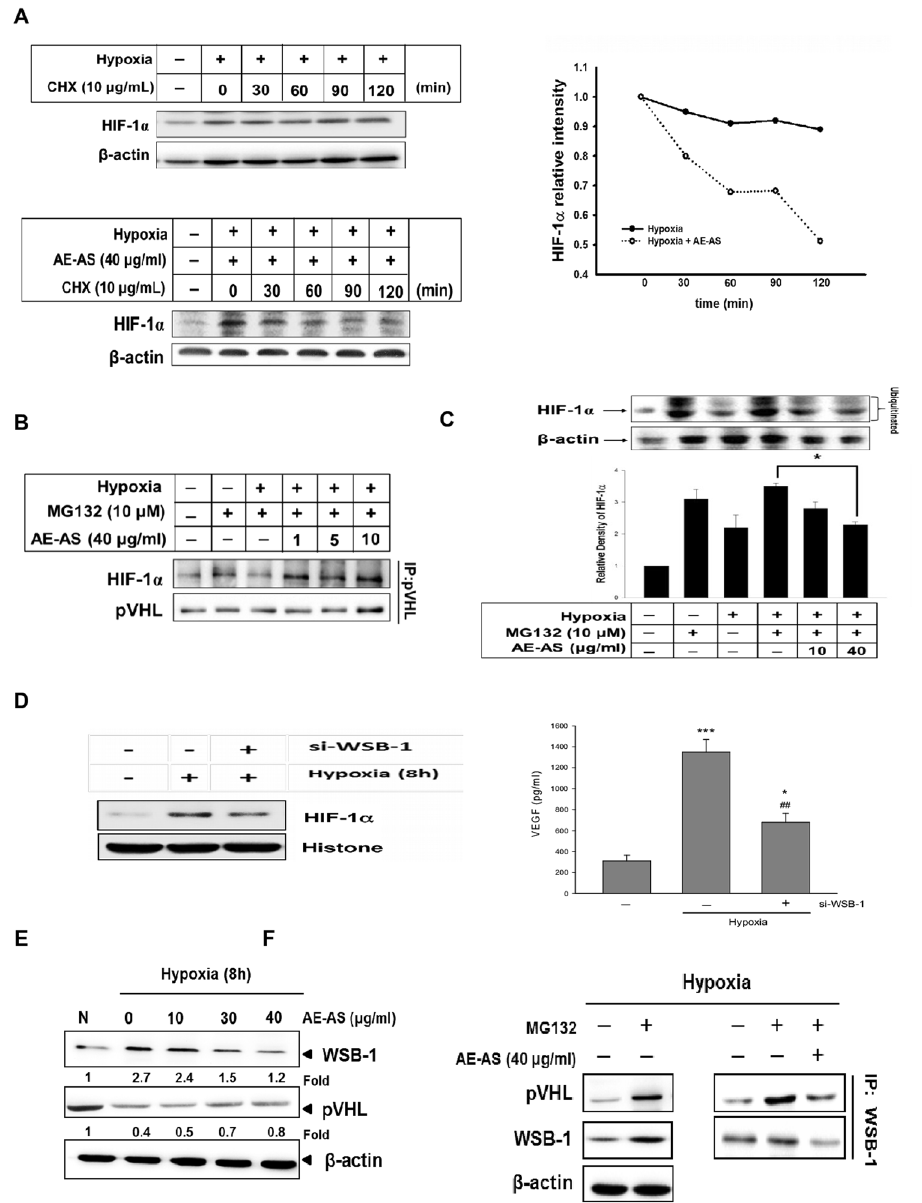
Figure 3. AE-AS decreased HIF-1 α protein degradation and synthesis, and WSB-1-pVHL interaction in hypoxic T24 cells. T24 cells were exposed to hypoxia for 8 h followed by addition of cycloheximide (CHX, 10 μ g/ml) in the presence or absence of AE-AS (40 μ g/ml) for different time periods. The HIF-1 α protein levels at indicated time were analyzed ( A ). In the presence of proteasome inhibitor MG132 (10 μ M) and hypoxia, the interaction of pVHL and HIF-1 α in various groups was examined ( B ). The T24 cells were pretreated with MG- 132 for 1 h followed by exposure of hypoxia for 8 h in the presence or absence of AE-AS, and the HIF-1 α protein levels were determined ( C ). Data was expressed as mean ± SEM (n = 5). * P < 0.05 versus hypoxia and MG132- treated alone cells. The nuclear protein level of HIF-1 α and VEGF synthesis in the presence or absence of si- WSB-1 in hypoxic T24 cells were analyzed ( D ). The expression of WSB-1 and pVHL ( E ), and the association of WSB-1 with pVHL ( F ) in various groups were determined. * P < 0.05, *** P < 0.001 versus normoxic cells; ## P < 0.01 versus hypoxia-treated alone